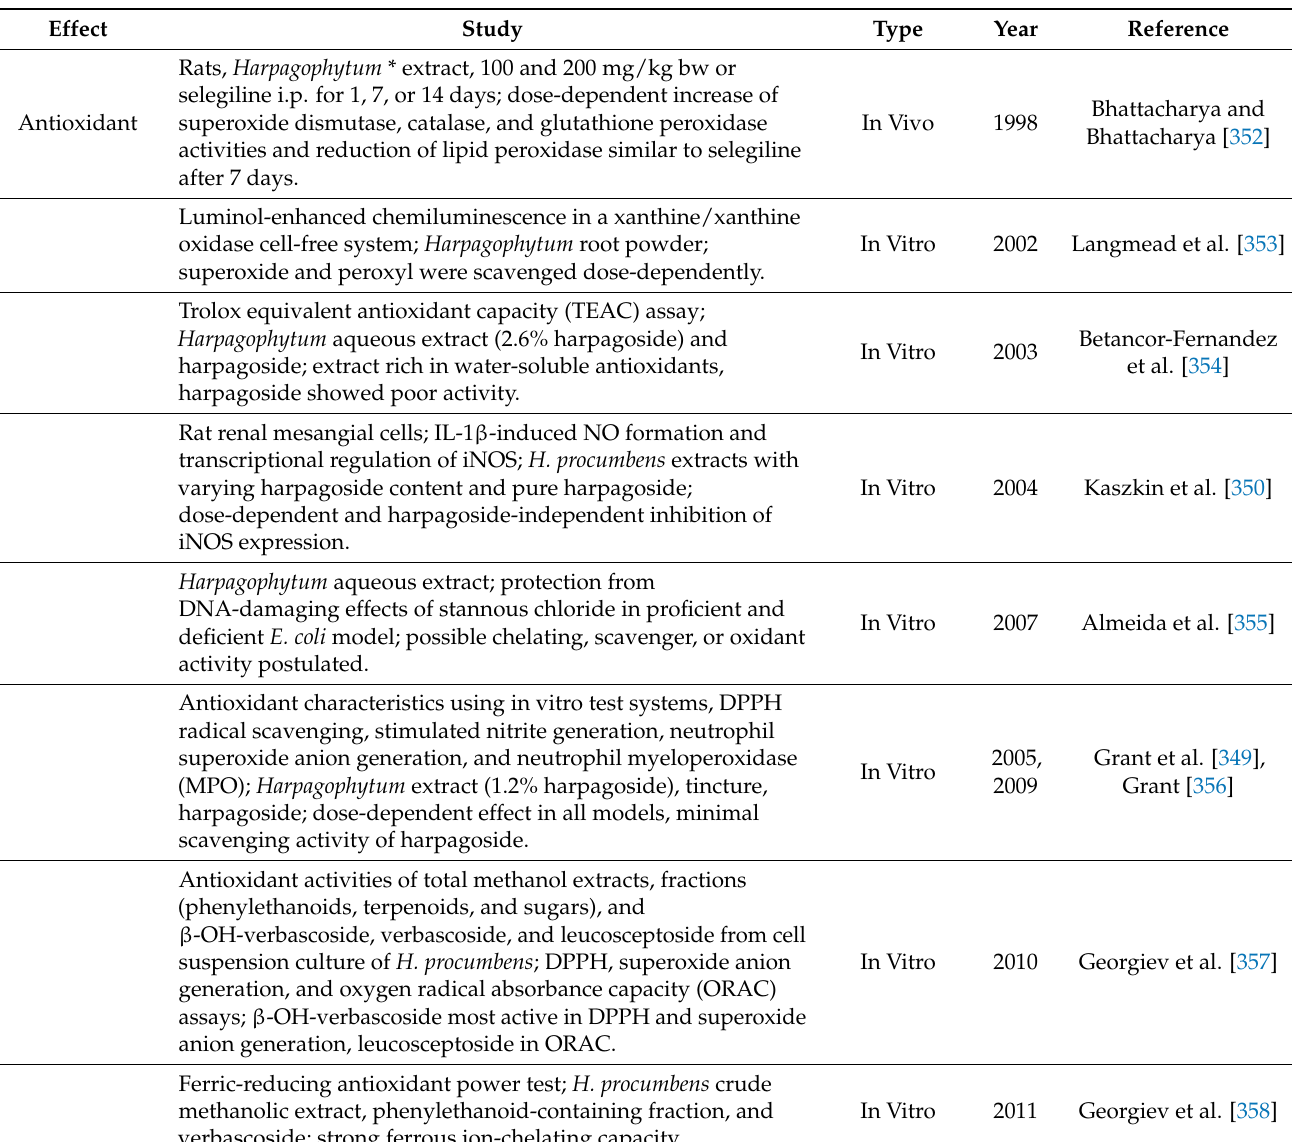
Table 9 summarizes the results of pre-clinical experiments which studied other effects of Harpagophytum and its compounds. Table 9. Experiments regarding other effects of devil’s claw preparations and